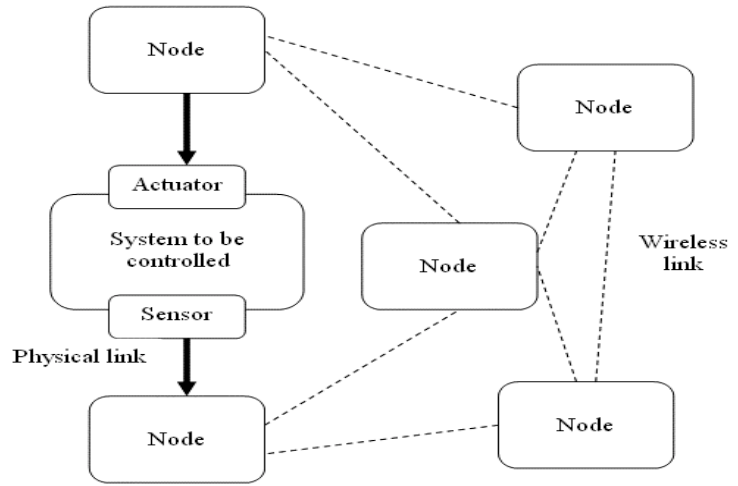
Figure 1. System general